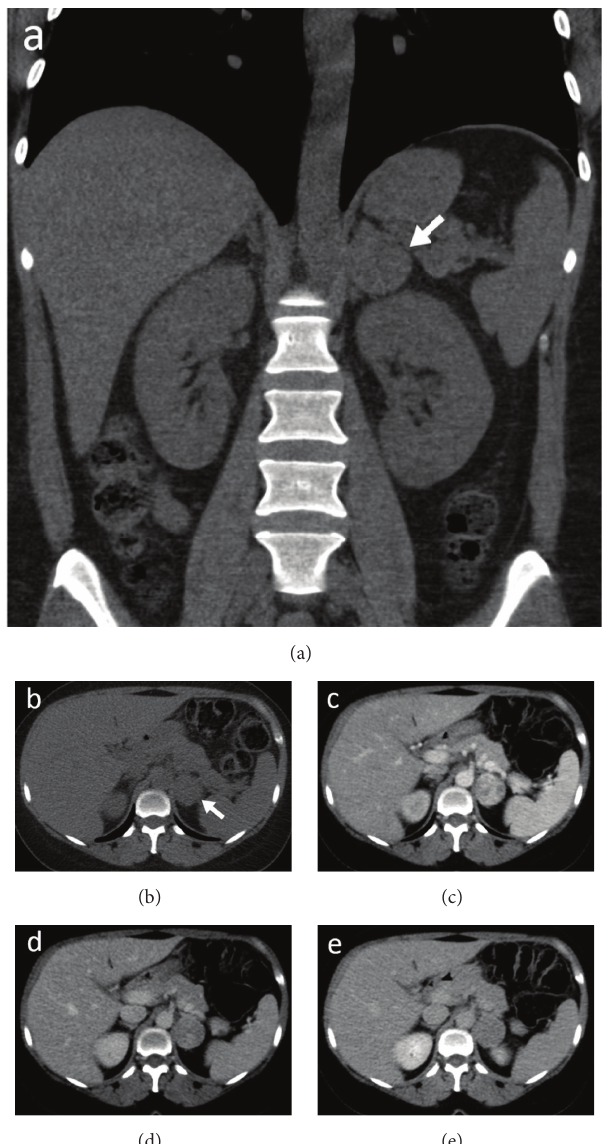
Figure 1: Coronal reformatted (a) and axial unenhanced CT images (b) show well-defined isodense mass in left adrenal gland measuring 3.5 cm in size. It is characterized by solid component (38 HU on unenhanced scan) (b), avid enhancement during arterial (c) and portal phases (102HU) (d), and mild washout during delayed phase (79 HU) (e).